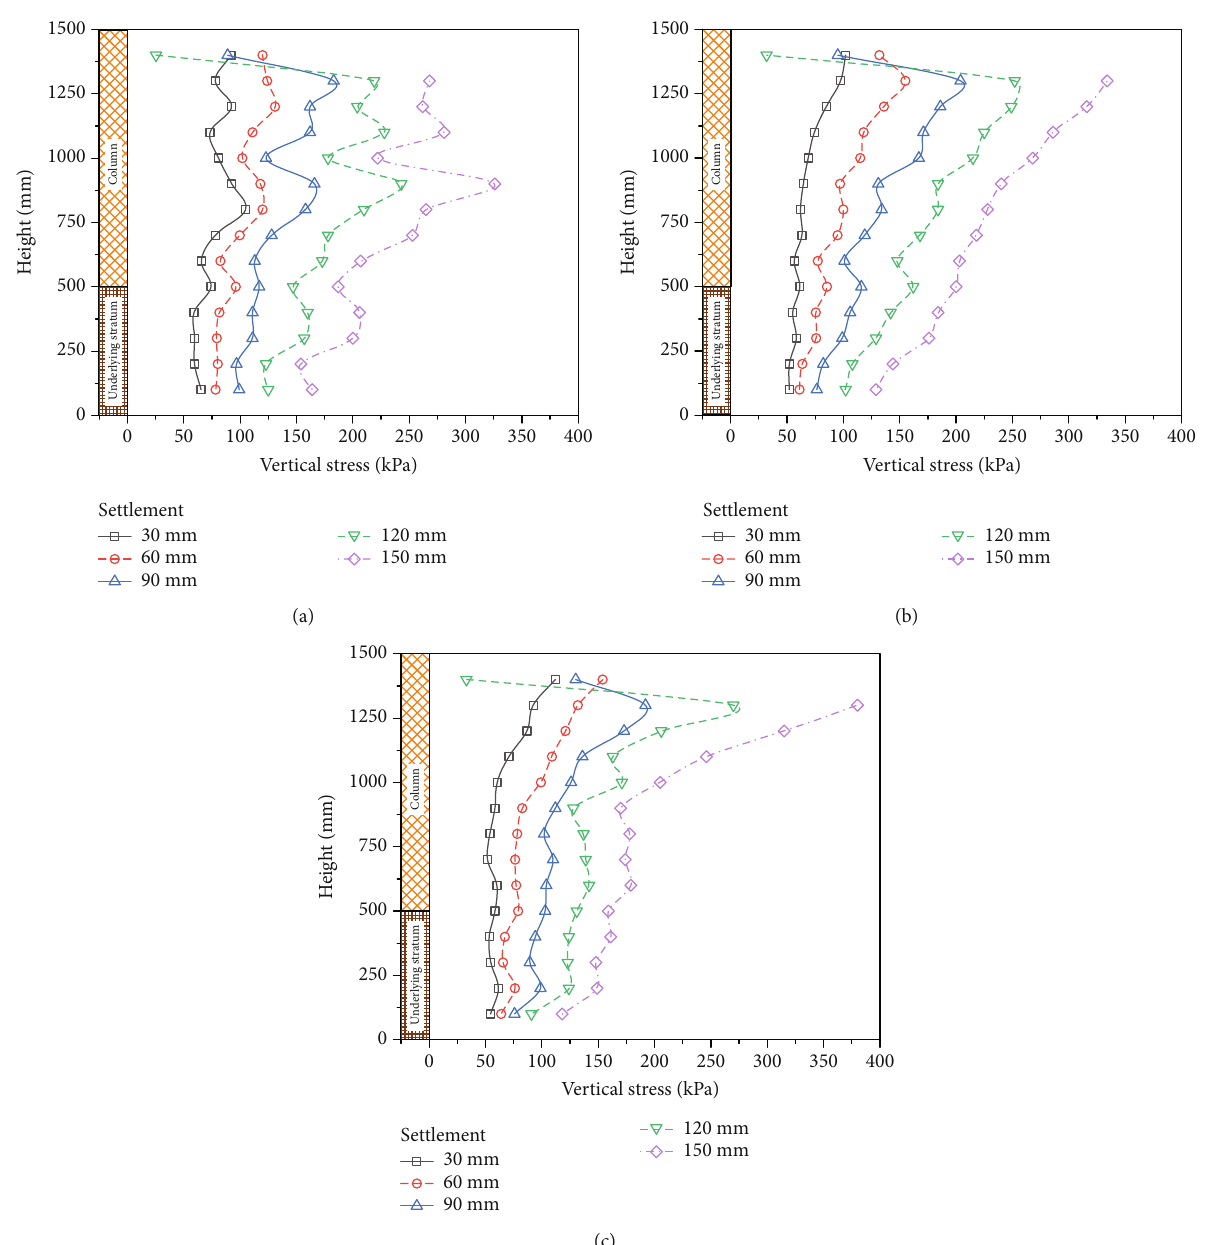
Figure 9: Vertical stresses of the soft soil: (a) 180 mm, (b) 280mm, and (c) 350mm away from the center of the